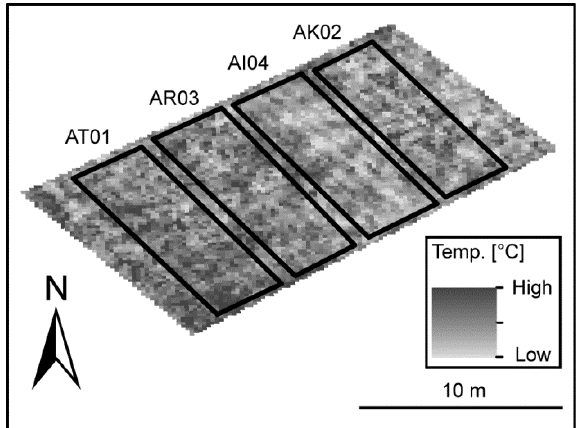
Figure 5. Measured temperature [°C] of different sugar beet types in plot batch 2 (see Figure